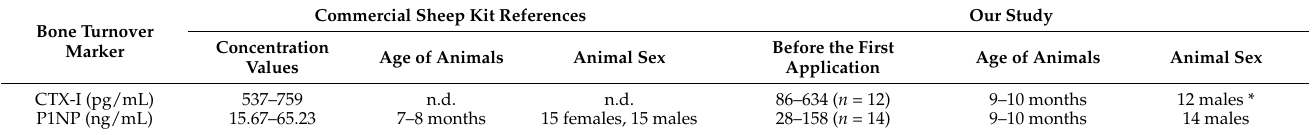
Table 2. Serum concentration of bone turnover markers of rams before the first BPA application compared with reference values for sheep from the manufacturer (MyBioSource, San Diego, CA, USA).